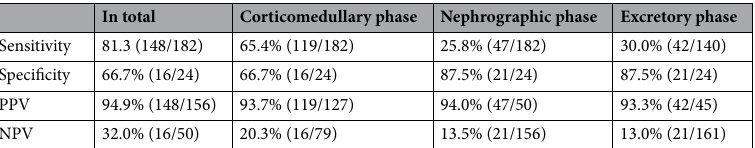
In total Corticomedullary phase Nephrographic phase Excretory phase